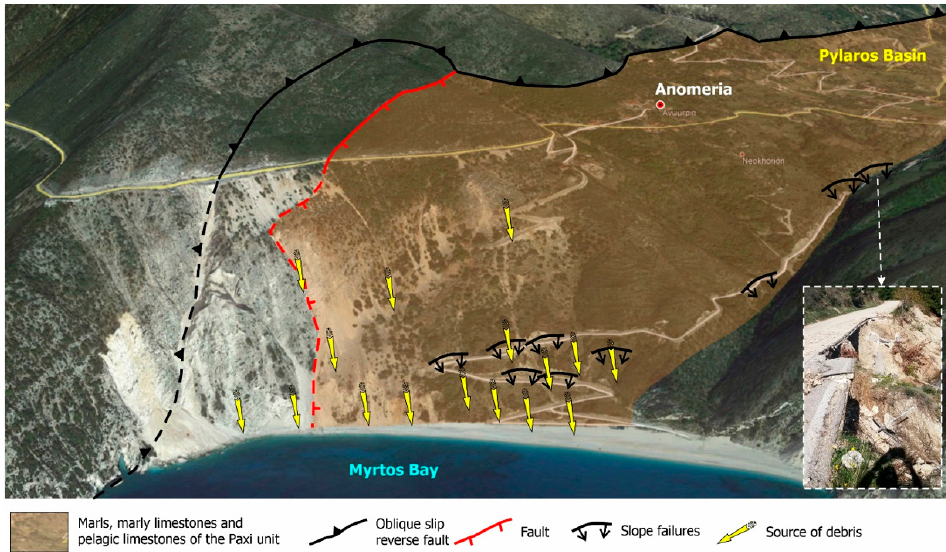
Figure 2. The morphological, geological, tectonic, and geotechnical context of the generation of destructive slope failures on the steep slopes of the Myrtos coastal area, based on geological field surveys in the area.